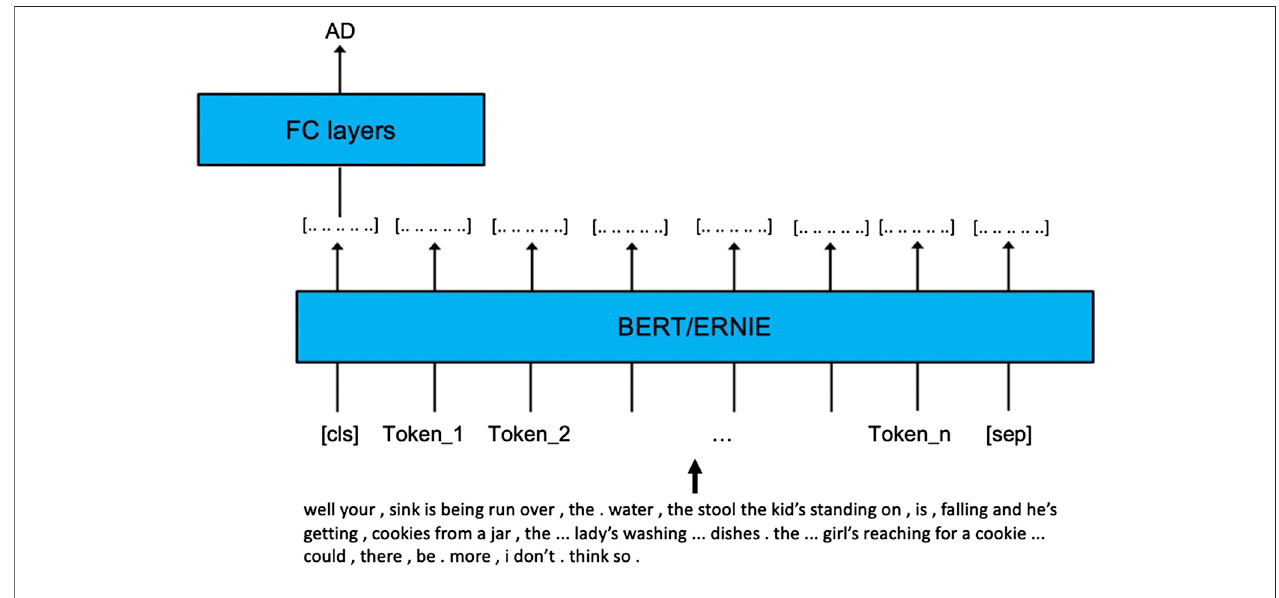
FIGURE 4 | Procedure for fi ne-tuning.